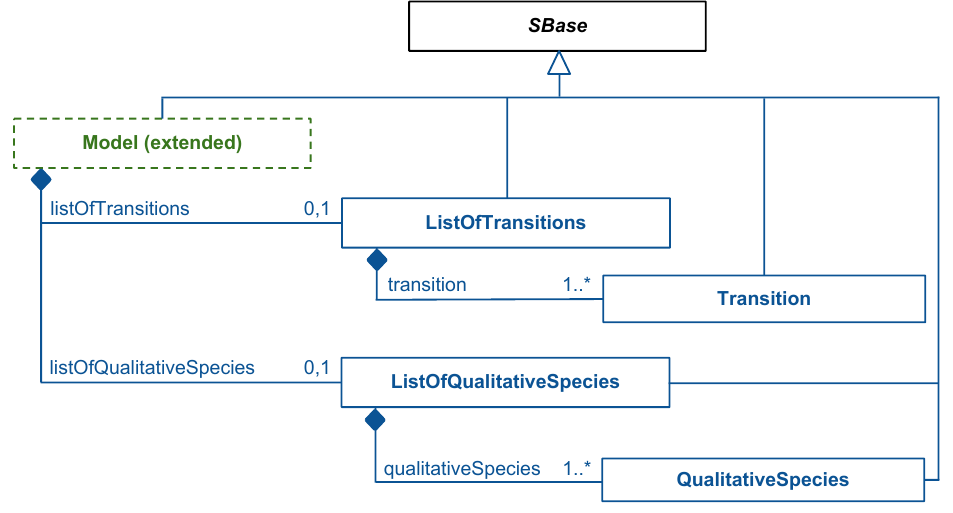
Figure 1: The definitions of the extended Model class. In other respects, Model remains defined as in the SBML Level 3 Core